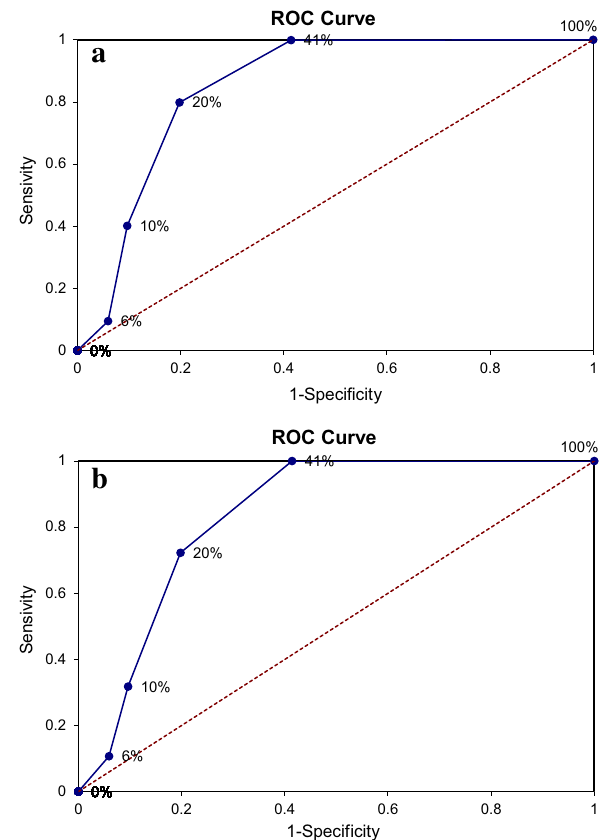
Fig. 7 Validation of groundwater potential map of a MIF and b AHP techniques by ROC